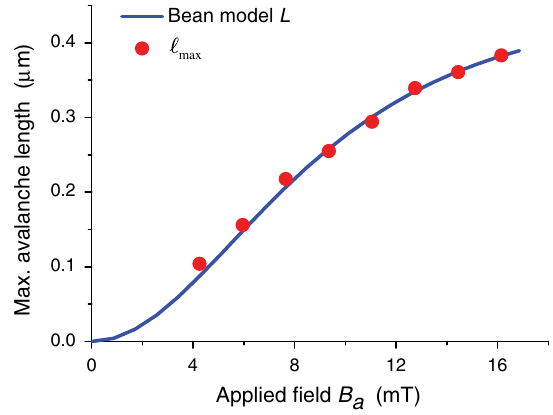
FIG. 4. Dependence of the maximum avalanche length, ‘ on the applied field (red dots). The solid blue curve shows the Bean-model flux penetration depth, L , given by Eq.